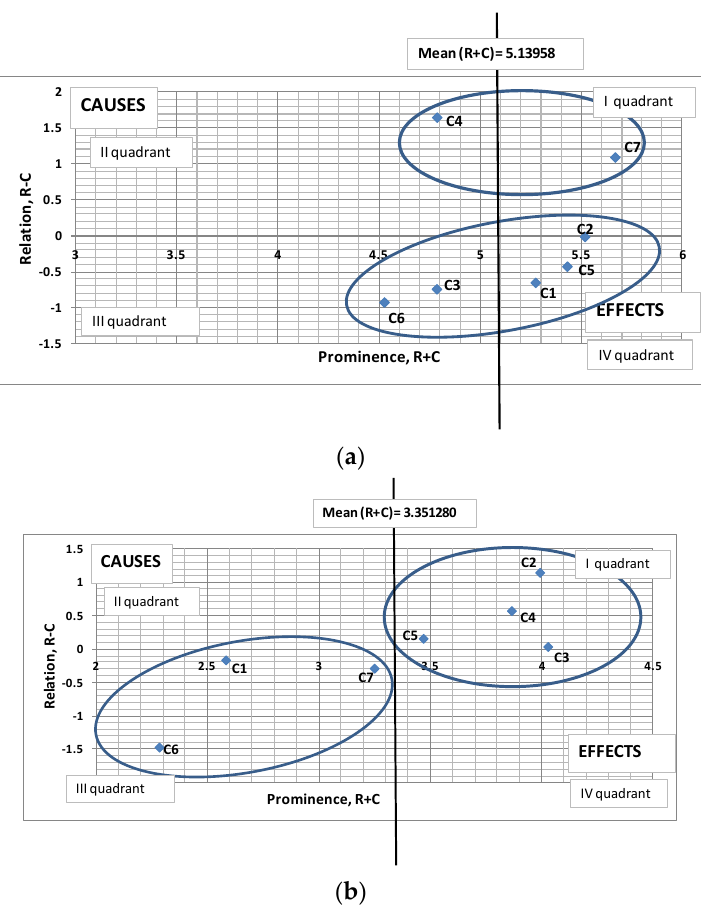
Figure 4. Results of DEMATEL application — individual assessments ( a ) DM1 ( b ) DM2.